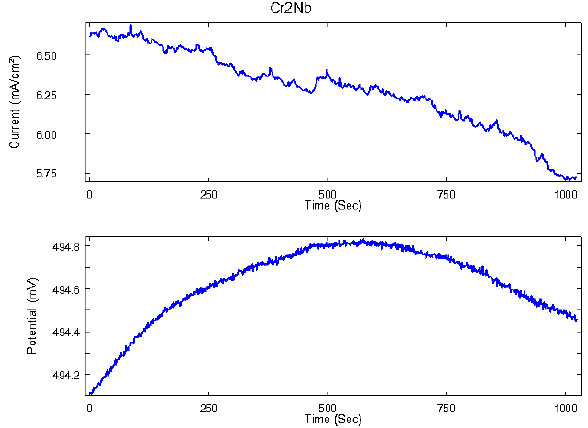
Figure 10. EN behavior at 20 h of milling.